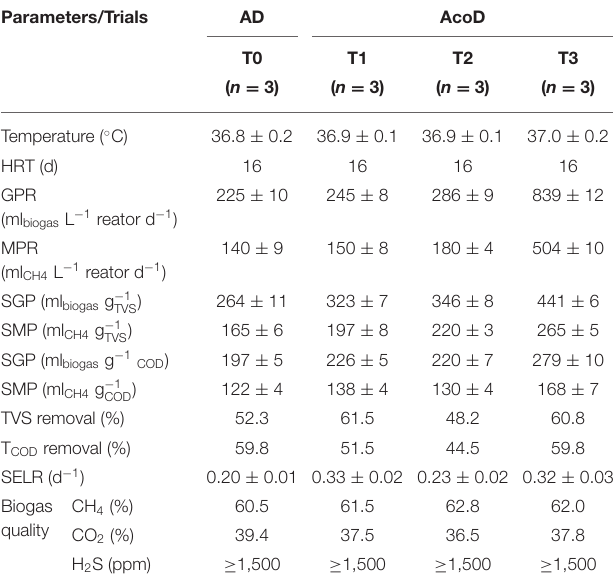
TABLE 3 | Average values of the operational parameters along the trials AD and AcoD.